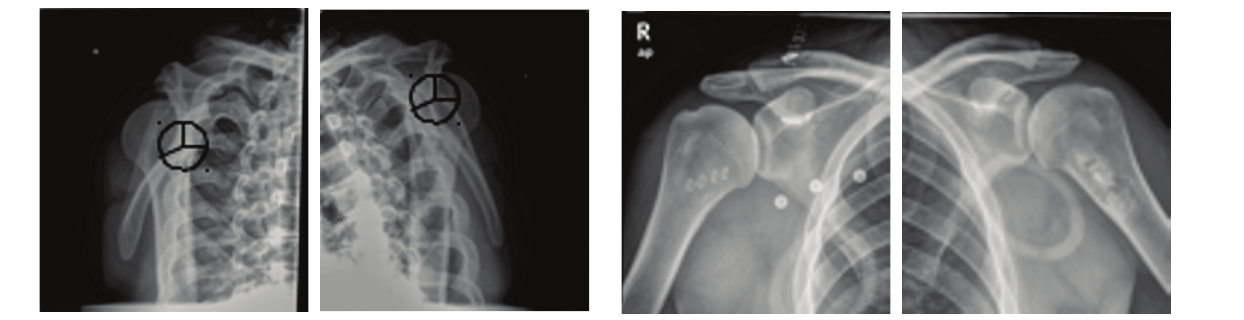
Figure 2. X - ray with outlet-view of right (R) and left (L) patient´s shoulder showing an empty glenoidal cavity and a decen- tered humeral head